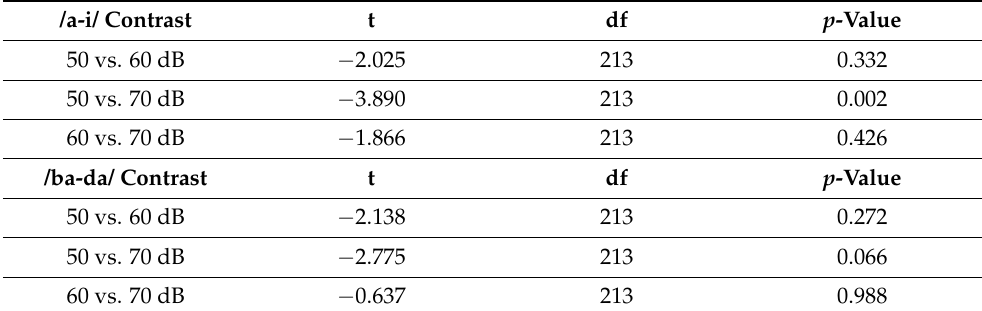
Table 5. Results of post-hoc tests on ANOVA in Table